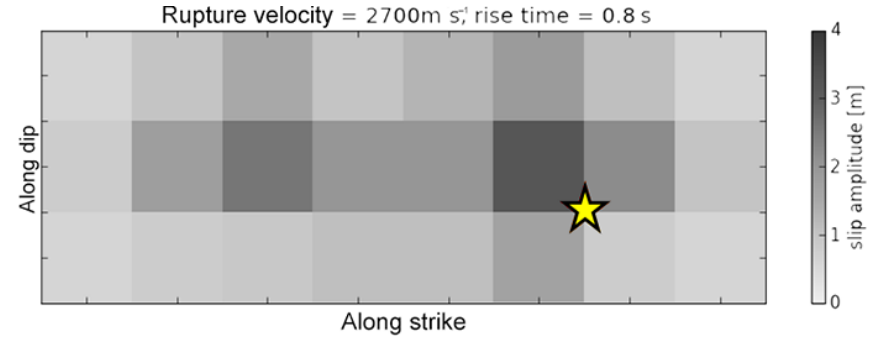
Figure 3. Illustration of the parameter space for the inversion. Rupture velocity and rise time are set to be homogeneous across the fault. There are 24 slip amplitudes, one for each subfault across the fault. The values range from 0 . 6m in the corners to 3 . 2m in one of the subfaults closest to the hypocenter (yellow star).